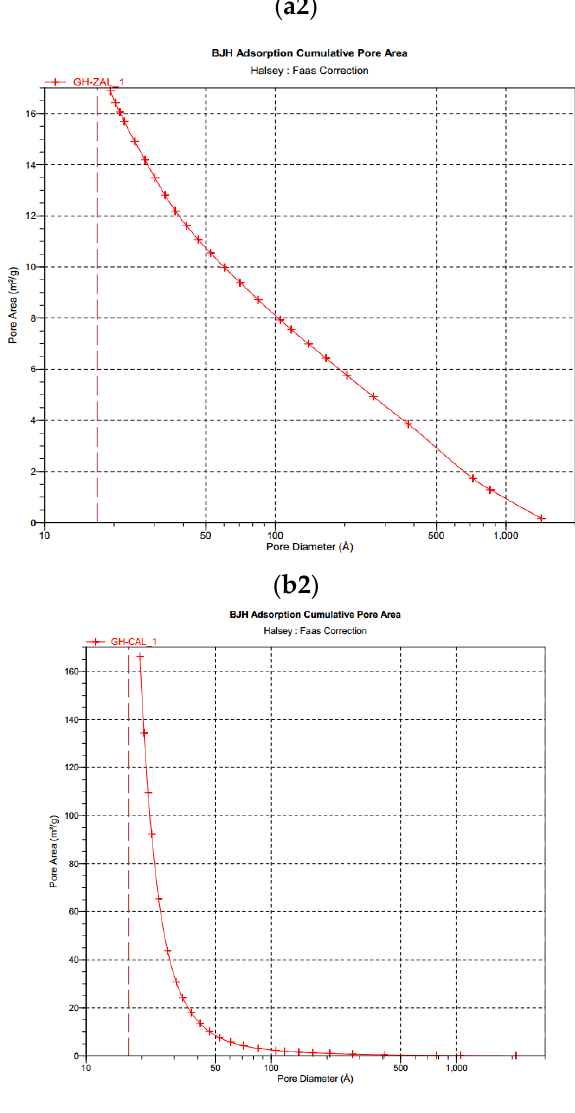
Table 3. Specific surface area, average pore diameter, and specific pore volume of adsorbents.